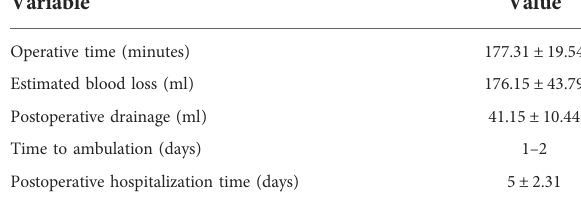
TABLE 3 Results related to